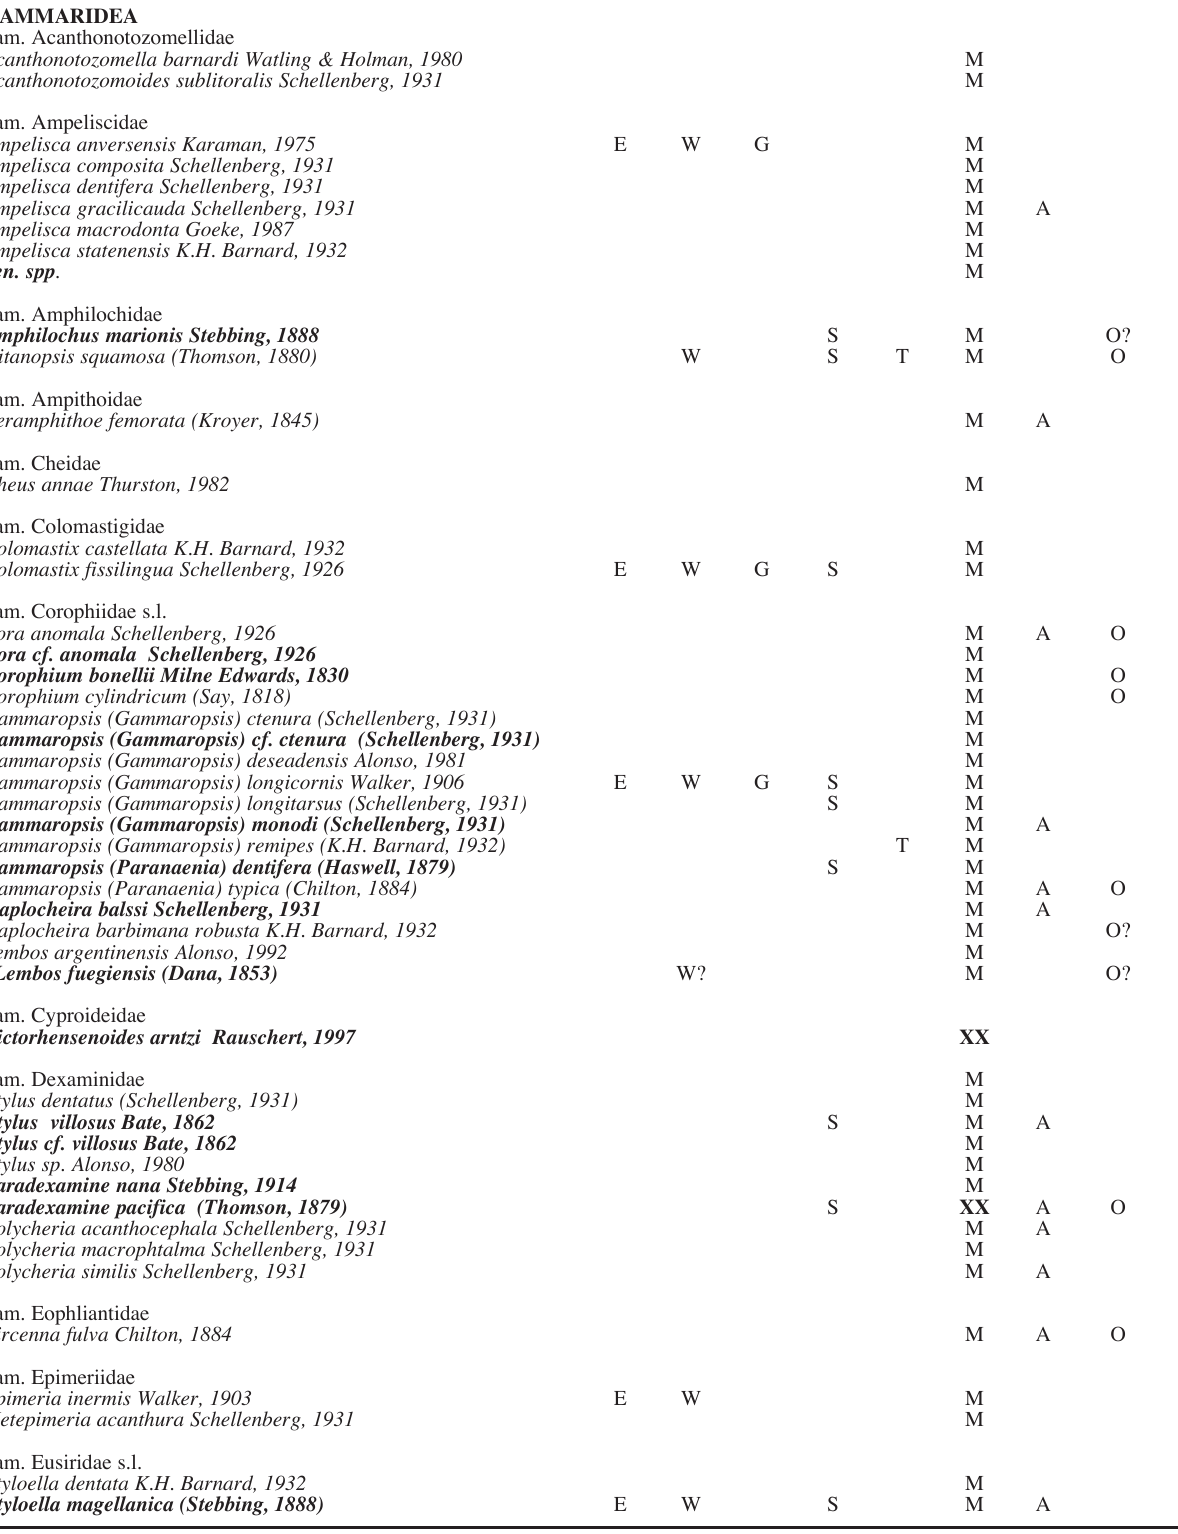
T ABLE 1. – List of benthic gammaridean and caprellidean amphipod species known from the Magellan sub-region (including the provision- al list of new records) and their occurrence in the East and West Antarctic sub-regions, the Subantarctic Islands sub-region and outside the Southern Ocean. Legend : E : East Antarctic sub-region; W : West Antarctic sub-region; G : South Georgia district; S : Subantarctic Islands sub- region; M : Magellan sub-region; A : South America (north to M); O : outside Southern Ocean and South America; XX : new records for the Magellan sub-region. New material listed in bold